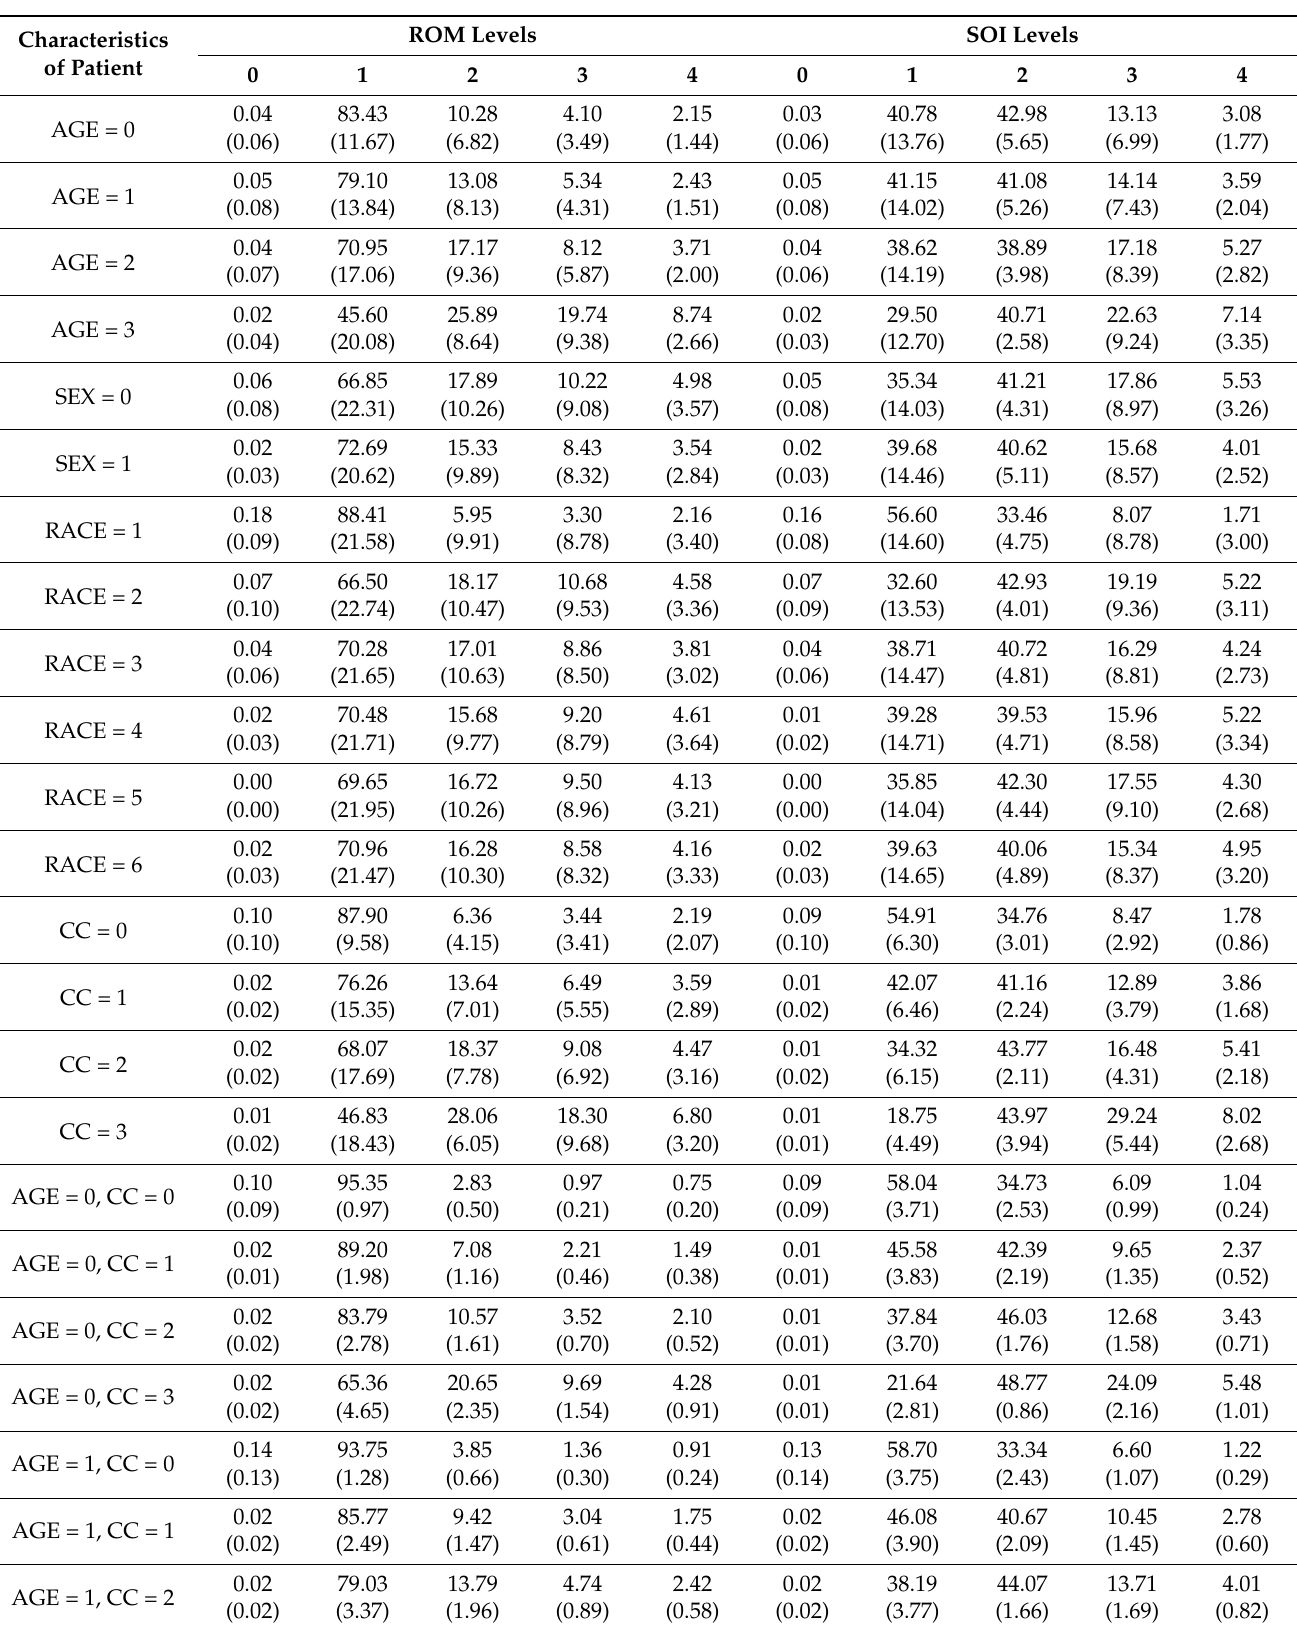
Table A1. Predicted probabilities corresponding to patient characteristics and ROM and SOI levels. The mean value (with its standard error) is reported, (calculation unit: